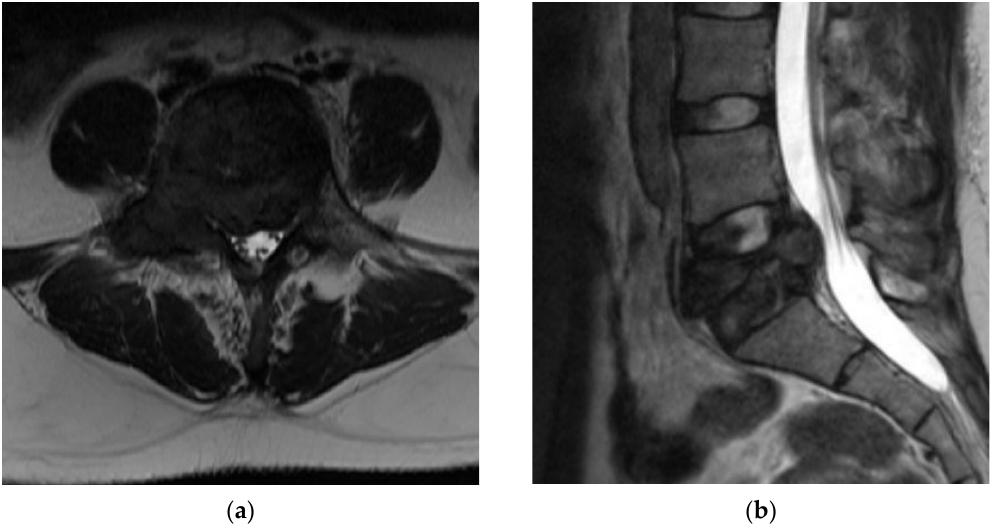
Figure 3. ( a ) Axial T2 weighted MRI cuts of L5 vertebral body show low signal intensity of the tumor body with extension into bilateral pedicles. There is mild compression of the spinal canal. ( b ) Sagit- tal T2 weighted MRI cuts of L5 vertebral body again show low signal intensity. There is retropulsion of the compressed L5 vertebral body causing narrowing of the canal.